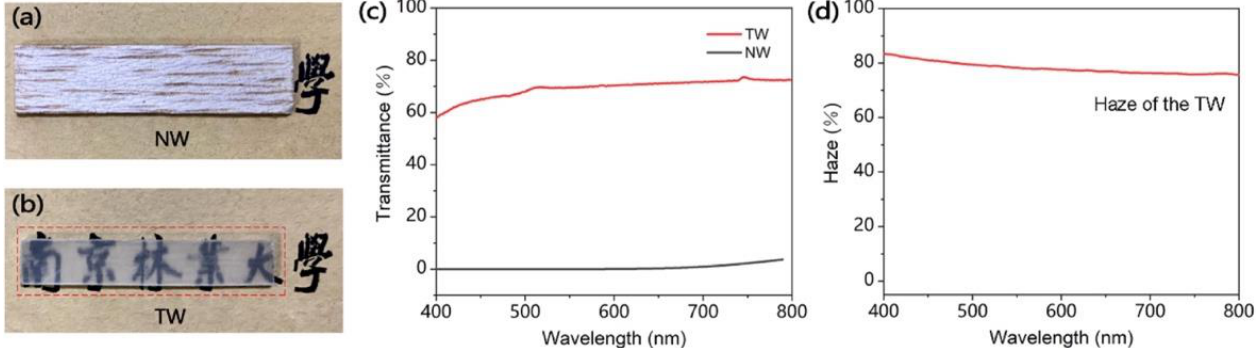
Figure 21. Mechanical properties of transparent wood. ( a ) Transparent wood becomes highly flexible upon bending. ( b ) Typical stress – strain curves of natural (pristine) wood (NW), delignified wood (DW), and transparent wood (TW). ( c ) Young’s modulus of NW, DW, and TW. ( d ) Resilience of the TW at different cycle numbers measured under 40% strain. Reprinted permission from [41], under CC-BY license.